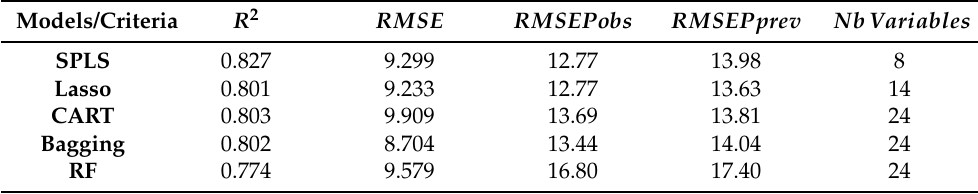
Table A1. Comparison table of parametric and nonparametric models according to the R 2 , RMSE , RMSEPobs , RMSEPprev , and Nb Varibales